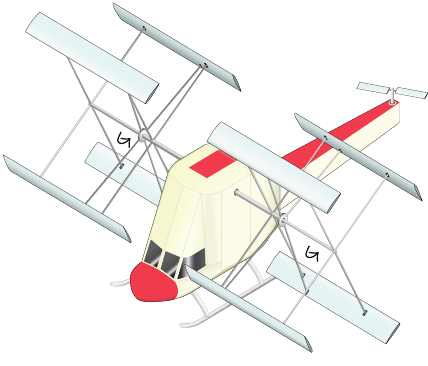
Figure 1: A spinning beam in a cyclocopter [14].